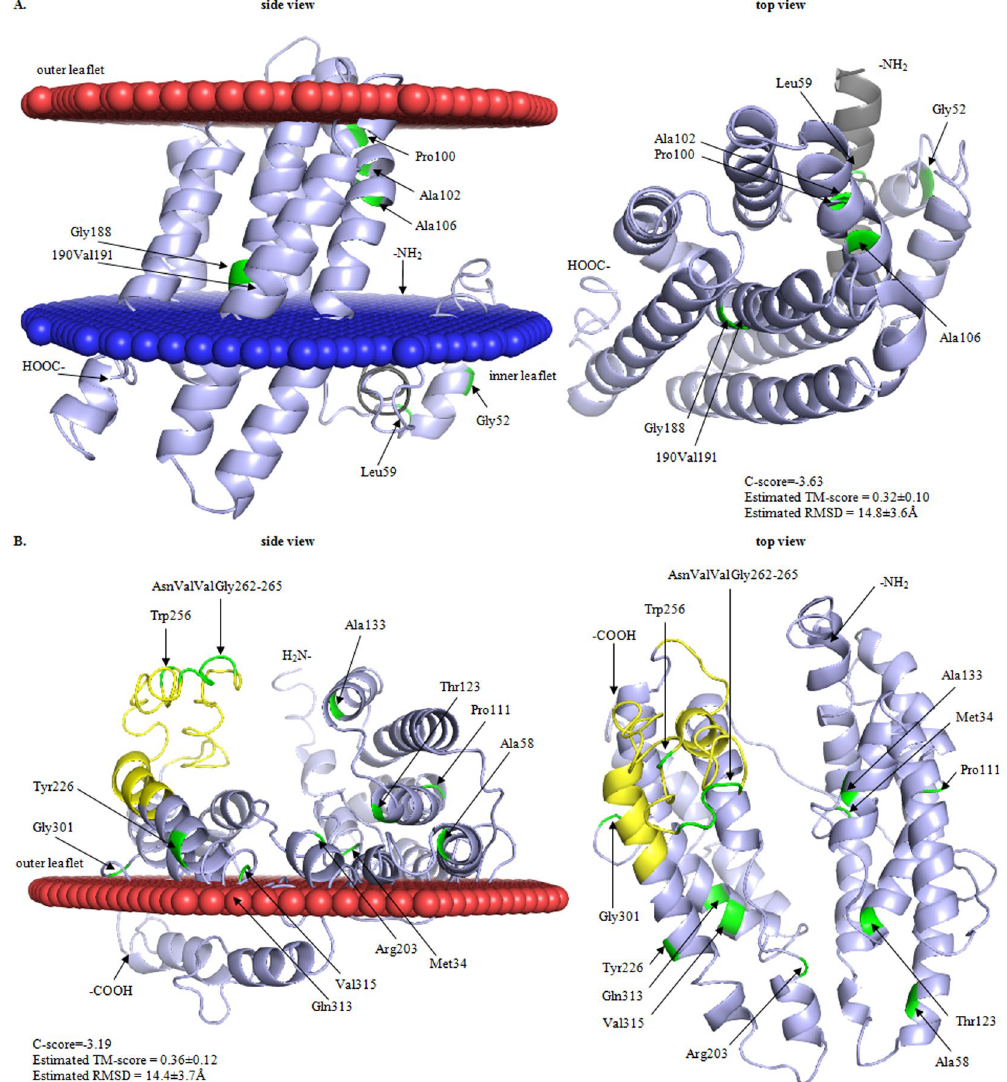
Figure 6. Predicted tertiary structure of L . garvieae IBB3403 Man-PTS subunits IIC ( A ) and IID ( B ). Amino acids changed by mutations, signal peptide and region γ+ are in green, grey and yellow, respectively. Lipid bilayer is represented by red (outer bilayer) and blue (internal bilayer) layers of spheres. C- and TM-scores estimate global accuracy of the 3D structure model. C-score in the range from − 5 to 2 and TM-score > − 1.5 indicates a model with correct global topology. RMSD is the average distance of pairs of residues between model and